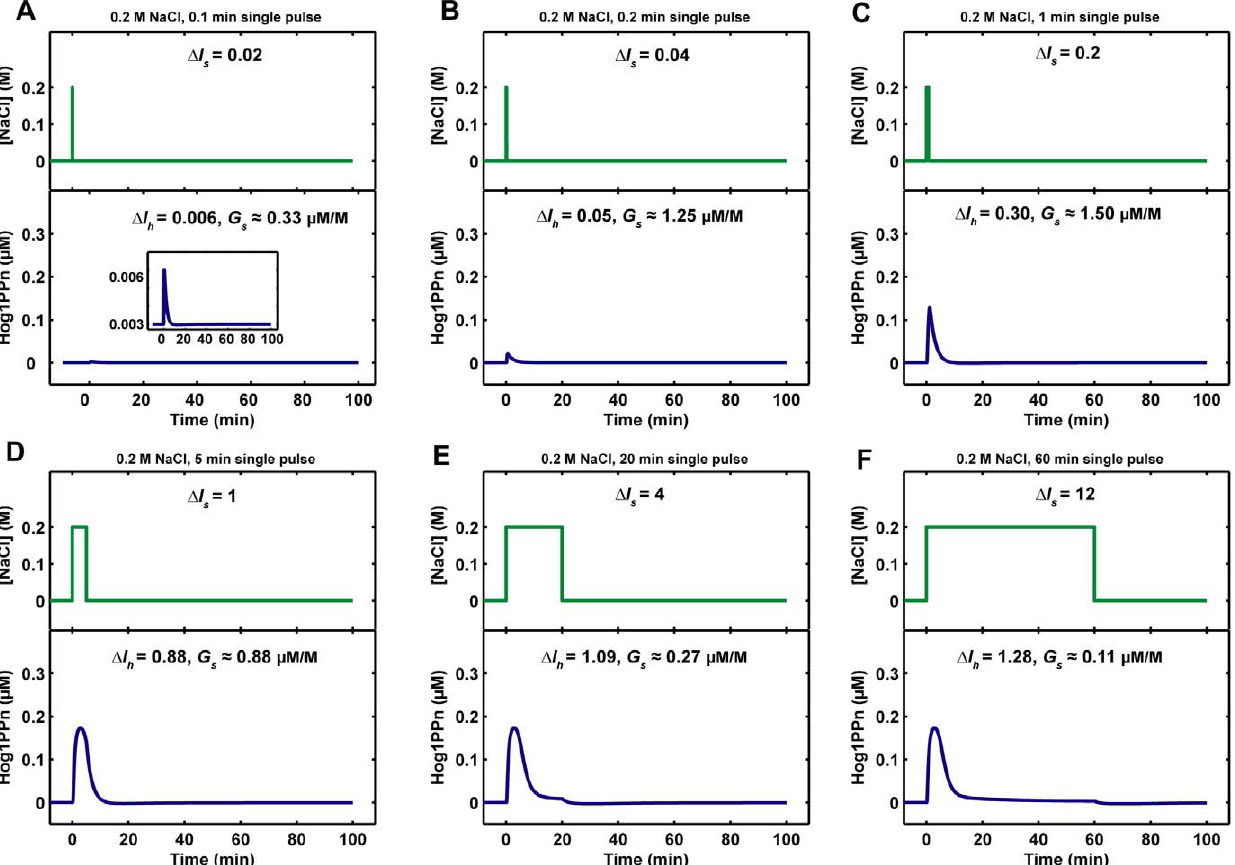
Figure 6. Nuclear phosphorylated Hog1 (Hog1PPn) response to single pulses of 0.2 M NaCl. D I s : NaCl integral change, D I h : integral change of Hog1PPn response, G s : Hog1PPn response gain. The intersection curve in the lower part of panel A is a zoom-in shown in different scale.